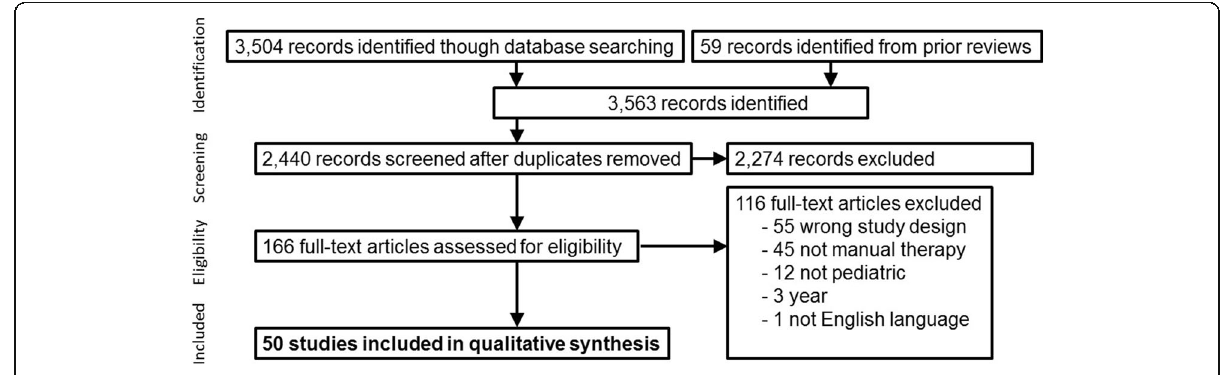
Fig. 1 Study selection flow diagram (PRISMA